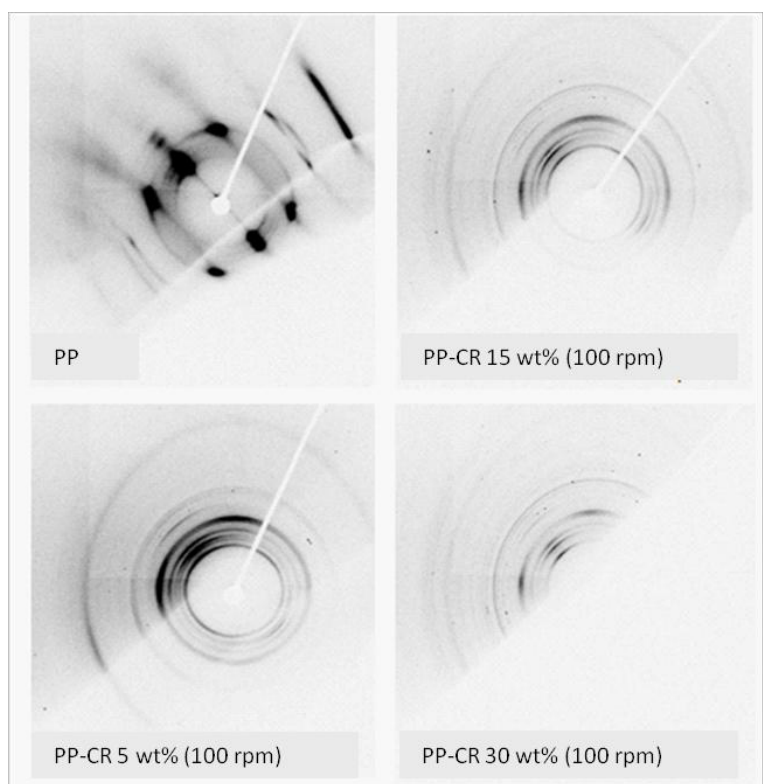
Figure 4. 2D diffraction images collected from PP and PP-CR composites (varying CR